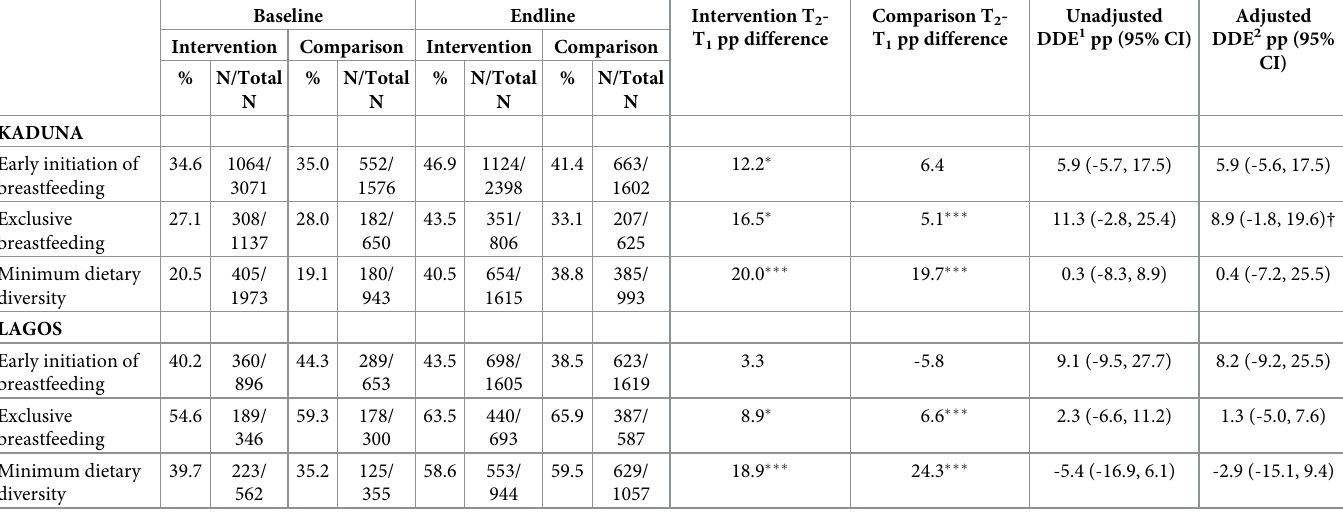
Table 2. Impact of Alive & Thrive on IYCF practices in Kaduna and Lagos States, Nigeria.